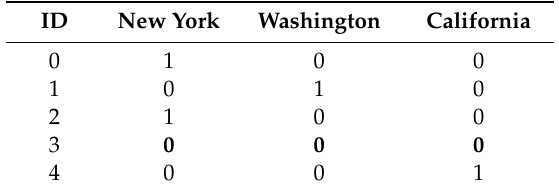
Table 6. One-hot encoding of the sample dataset given in Table 5.